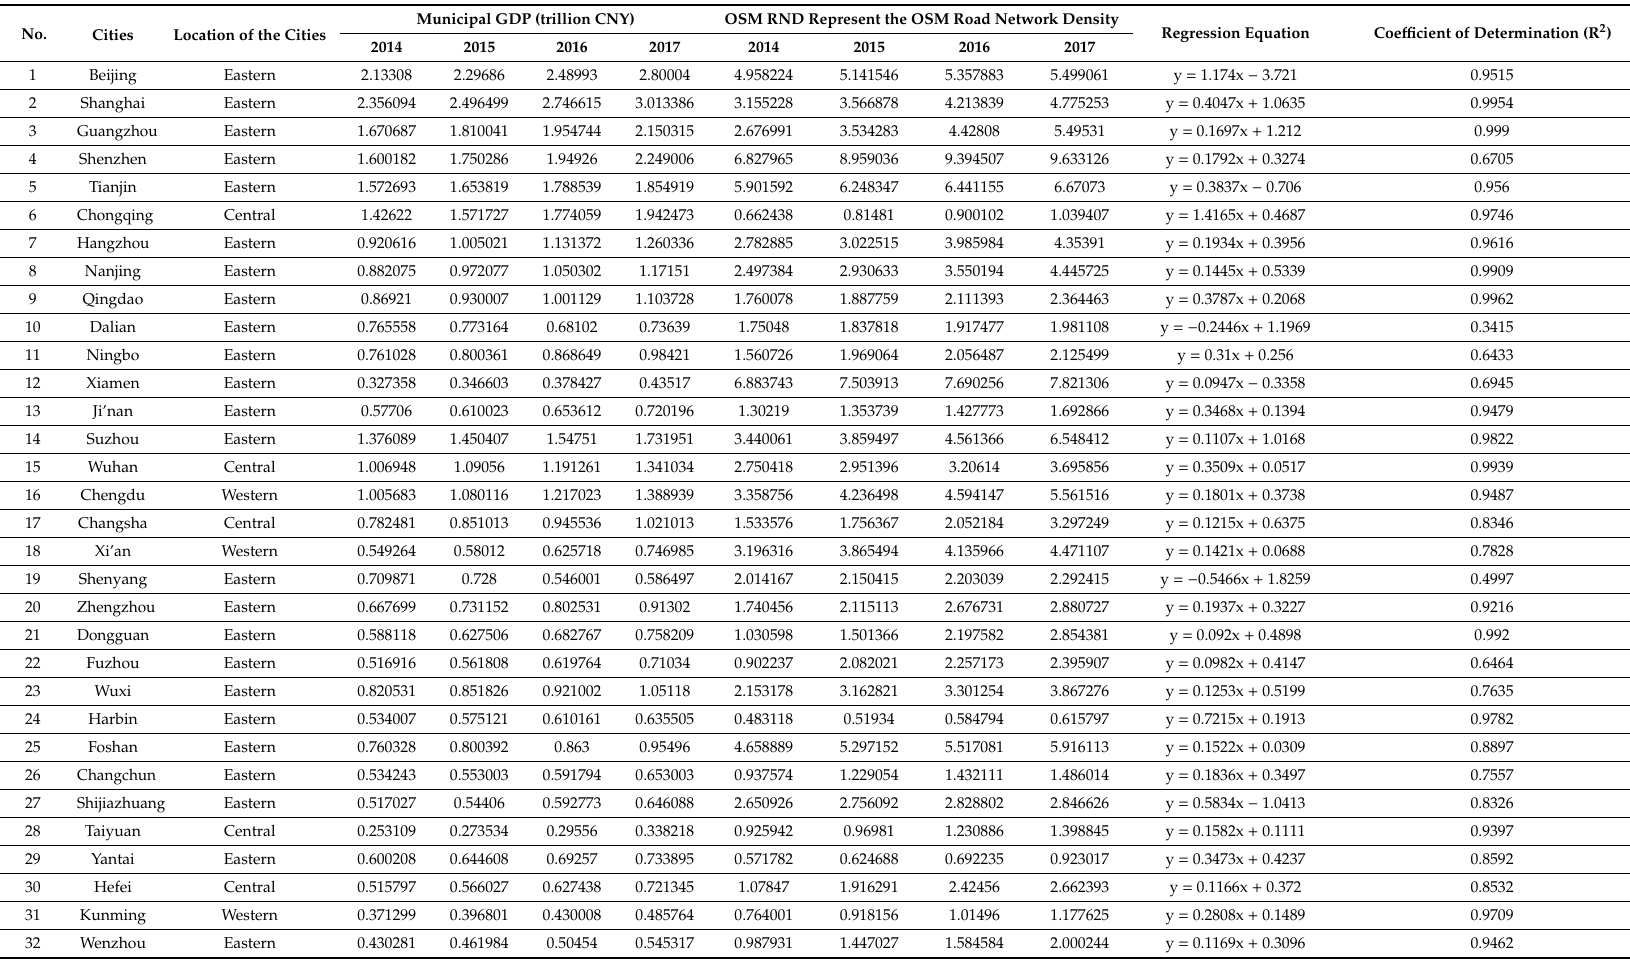
Table A1. The statistical results of the municipal GDP, coe ffi cient of determination R 2 , and regression equation of 85 Chinese cities from 2014 to